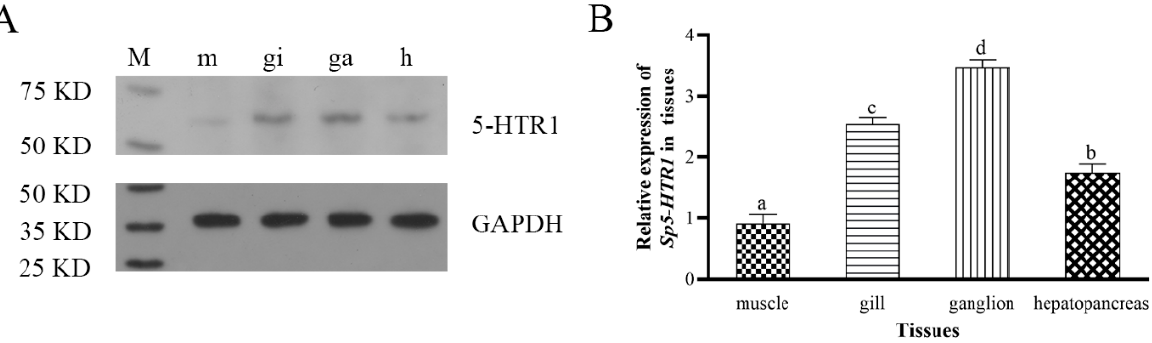
Figure 3. ( A ) Relative expression levels of Sp5–HTR1 in the tissues of S. paramamosain . GAPDH